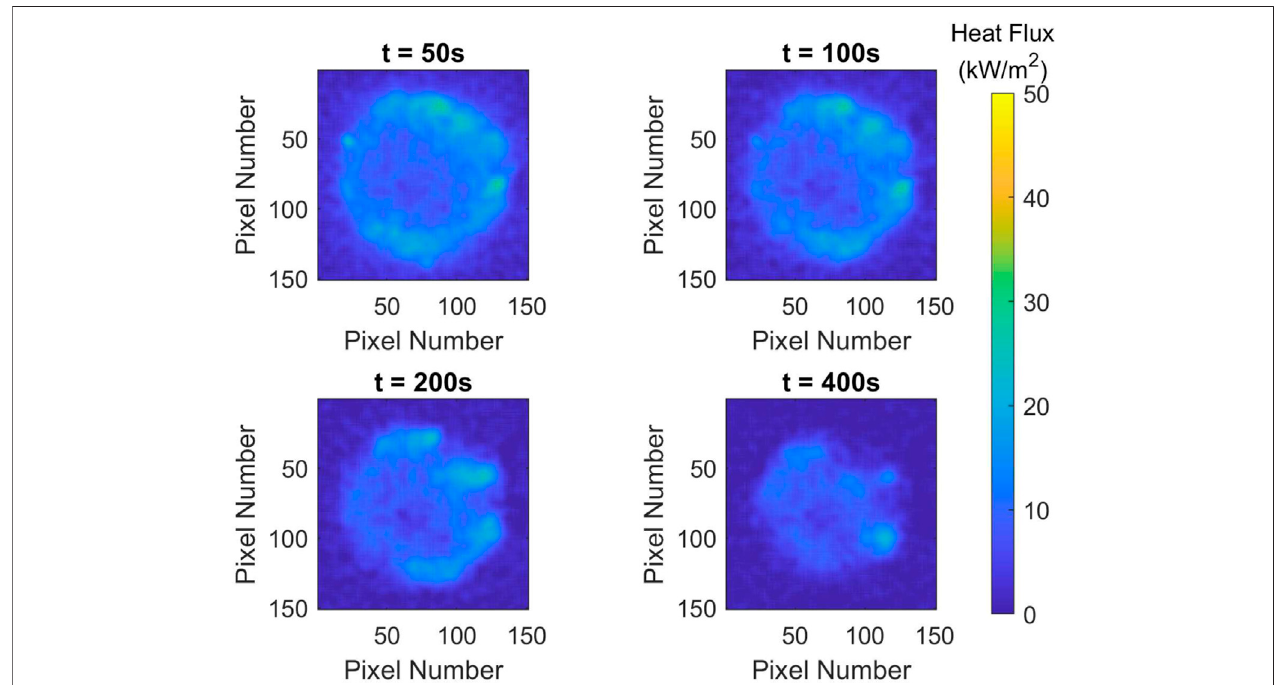
FIGURE 11 | Heat fl ux distribution for test FF6 at different times. Firebrands: D (cid:2) 4.75 mm, L (cid:2) 50.0 mm, and AR (cid:2) 10.5; Pile mass of m (cid:2) 3.0 g; Wind speed: U (cid:2) 0.0 m/s.